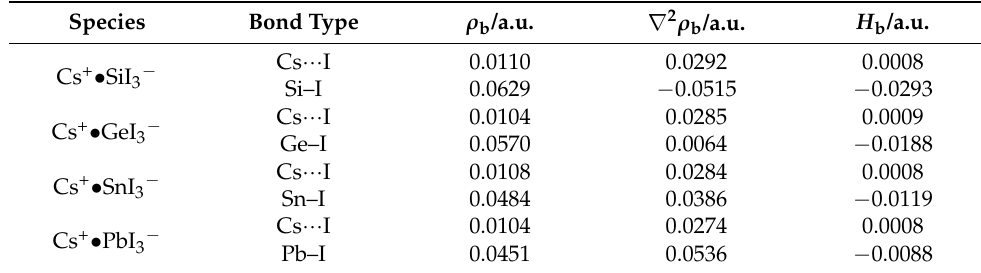
Table 1. Selected QTAIM-based topological charge density properties at Tt–I and Cs ··· I bcps